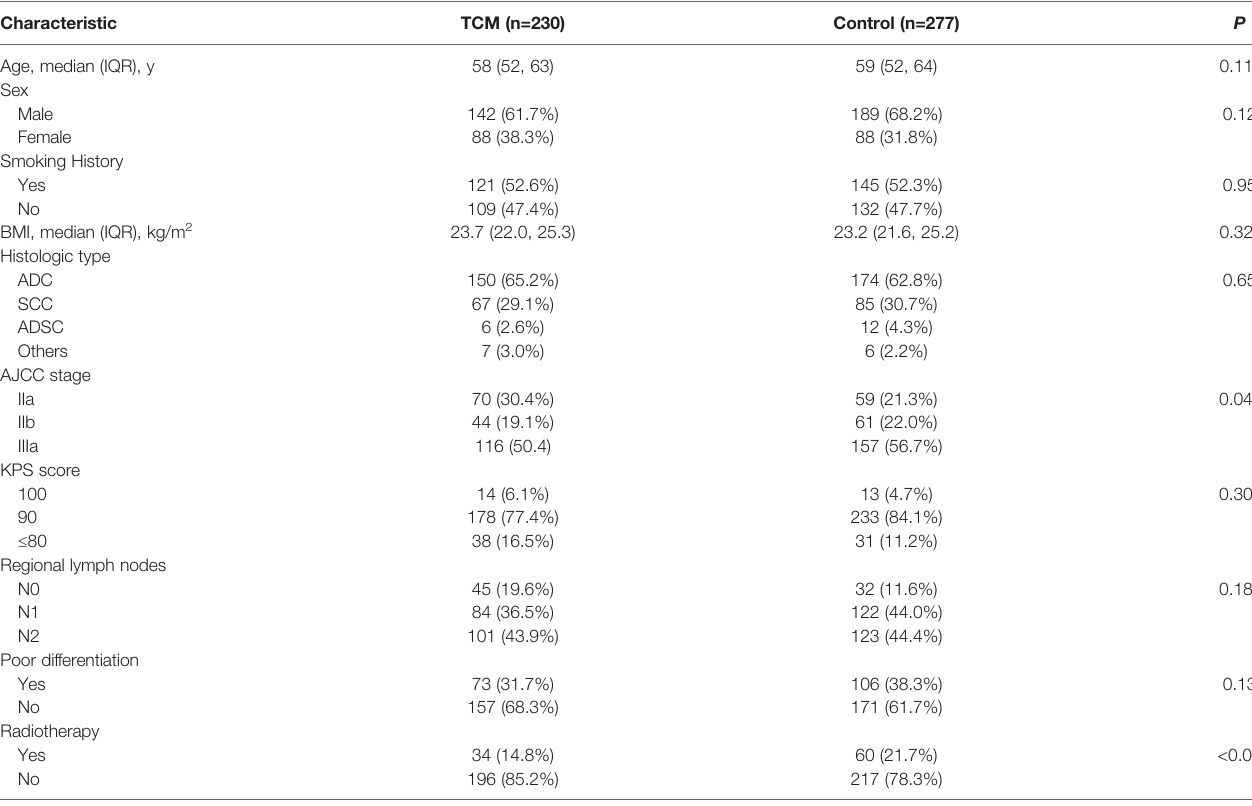
TABLE 1 | Demographic and Clinical Characteristics of Patients at baseline.